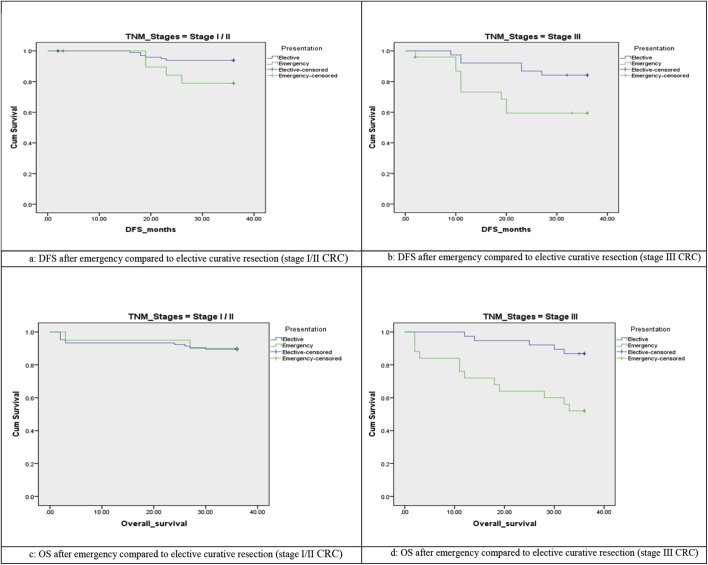
Survival curves after curative resection of colorectal cancer in the same TNM stage in both groupsFig. 1a: DFS after emergency compared to elective curative resection of stage I/II tumors. Fig. 1b: DFS after emergency compared to elective curative resection of stage III tumors. Fig. 1c: OS after emergency compared to elective curative resection of stage I/II tumors. Fig. 1d: OS after emergency compared to elective curative resection of stage III tumors.